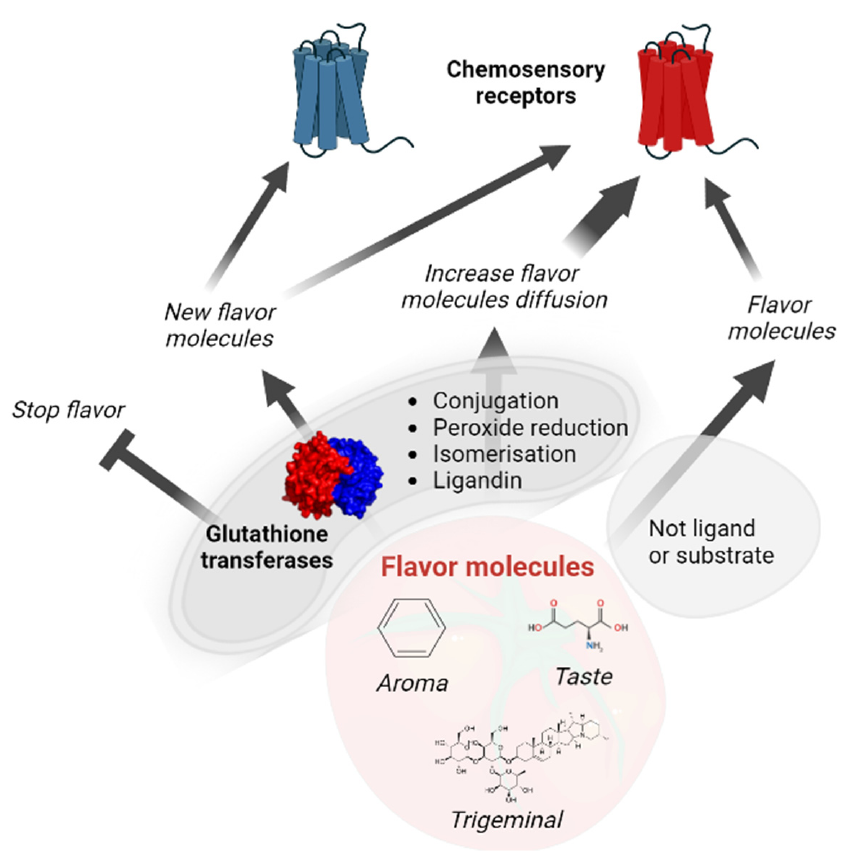
Figure 1. Role of glutathione transferases in chemosensory modulation.